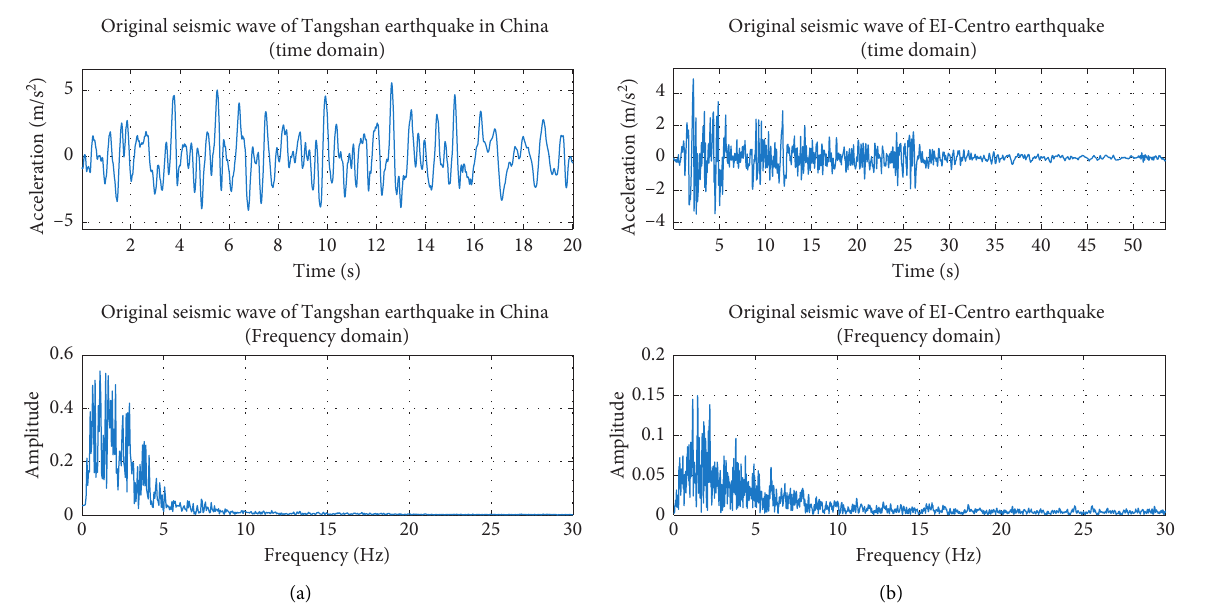
Figure 2: Seismic acceleration time history graph and frequency spectrum